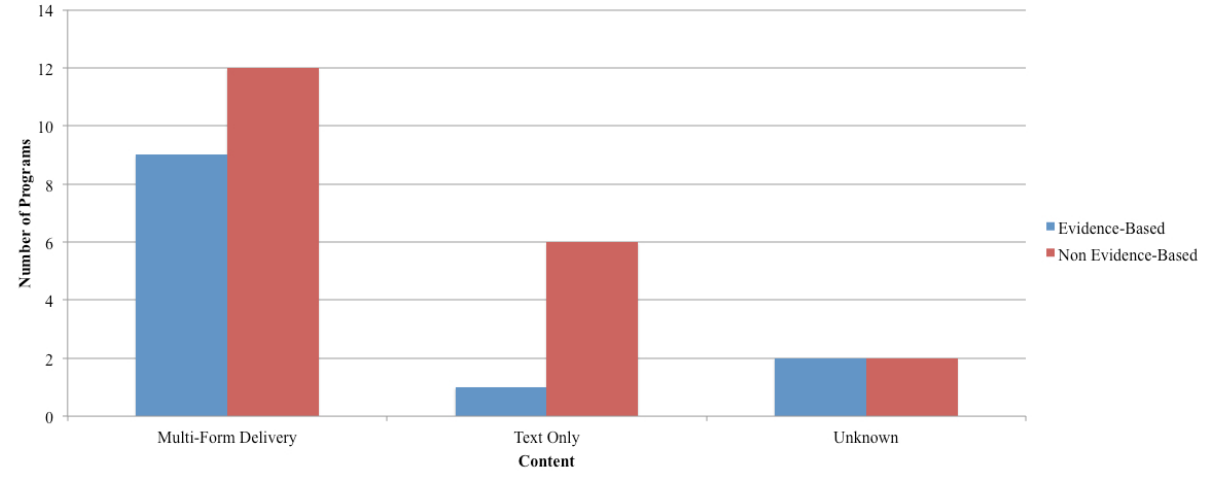
Figure 6. Method of content